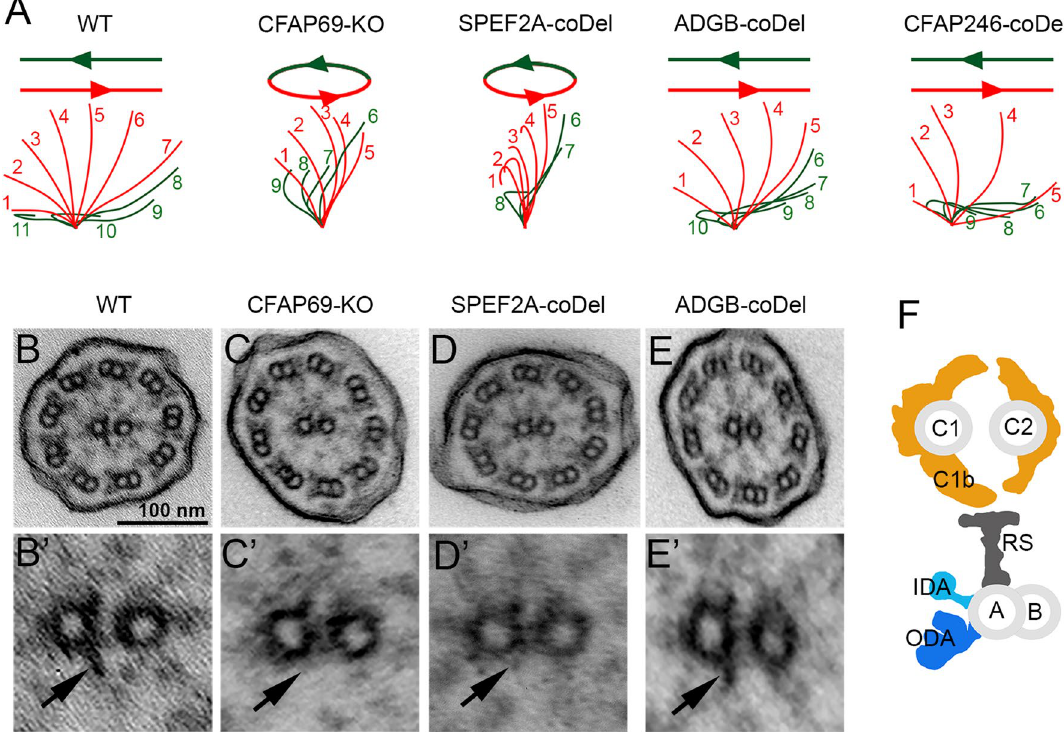
Figure 3. Cilia assembled by Tetrahymena CFAP69-KO or SPEF2A-coDel mutants lack C1b projection and exhibit a rotatory movement. ( A ) Drawings representing subsequent positions of the cilium during the power (red) and recovery stroke (green) of wild-type and mutant cells prepared based on analyzed movies. ( B–E ) TEM analyses of the ultrastructure of cilia assembled by wild type, CFAP69-KO , SPEF2A-coDel and ADGB-coDel mutants. ( B’–E’) The magnified images of the CA of cilia shown in ( B–E ). Note a lack of a large C1b projection in CFAP69-KO and SPEF2A-coDel mutants. ( F ) A drawing showing CA and a selected outer doublet with associated complexes. C1, C2 – microtubules of the CA, C1b – projection missing in analyzed mutants, RS – radial spoke, IDA – inner dynein arm, ODA – outer dynein arm, A, B – tubules of the outer doublet. Drawing was prepared based on cryo-ET images of ciliary structures presented in 2,3 or missing in CFAP69-KO and SPEF2A-coDel cilia (Figs. 3B-D’,F, S5). Thus, likely both proteins are crucial for either the assembly or stability of the C1b complex. In some ADGB-coDel cilia, C1b seemed smaller or twisted (Figs. 3E-E’, S5). In contrast, CFAP246-coDel cilia did not have obvious defects. In Tetrahymena the C1f projec- tion is not that apparent in TEM cross-sections as in Chlamydomonas flagella cross-sections. However, because in Chlamydomonas cpc1 mutants both C1b and C1f projections are lost, it is possible that also in Tetrahymena the entire C1b/C1f region is lost and therefore we will further refer to CFAP69-KO and SPEF2A-coDel knockouts as C1b/C1f-less mutants.